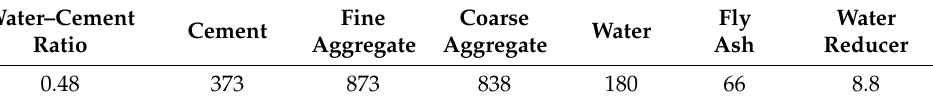
Table 1. Mix proportions of concrete (kg/m 3